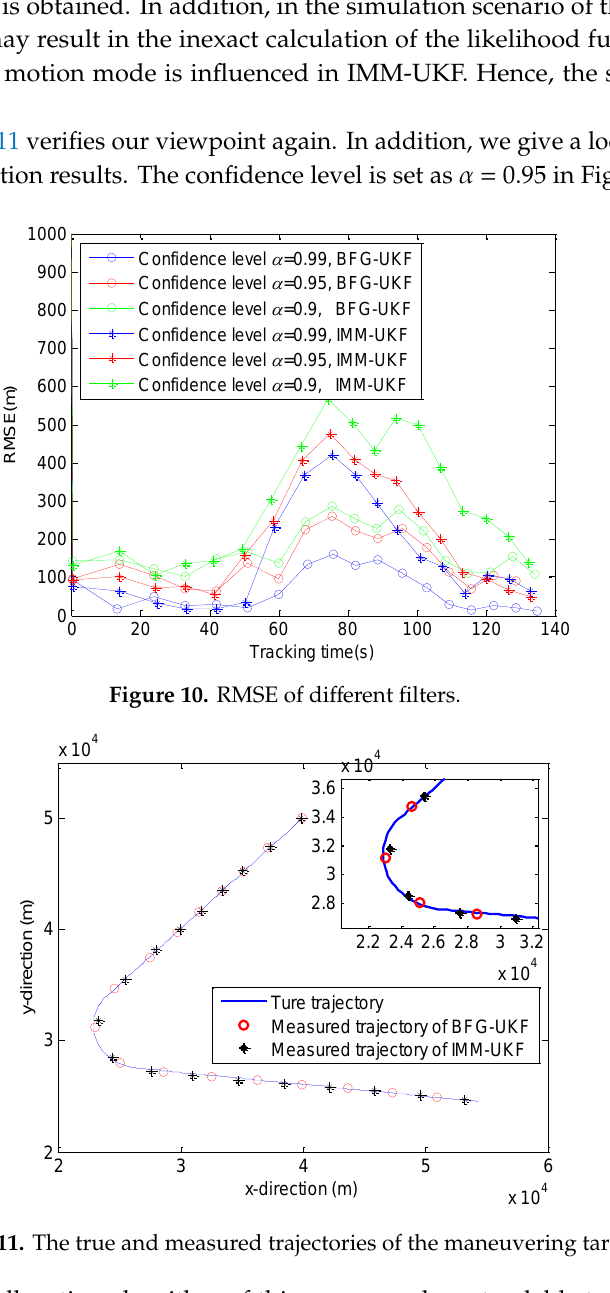
Figure 11. The true and measured trajectories of the maneuvering target.